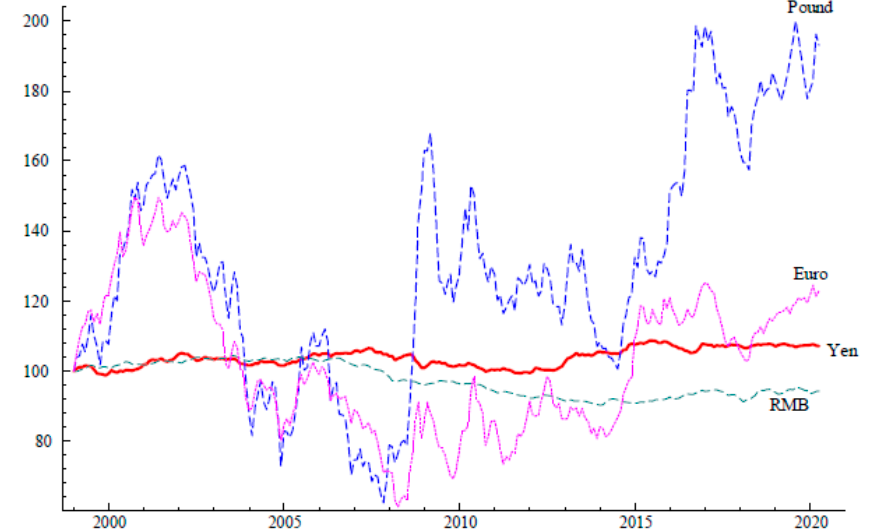
Figure 2. Bilateral Real Exchange Rates for the Currencies in the Special Drawing Right (SDR). Series are set 1999 = 100.